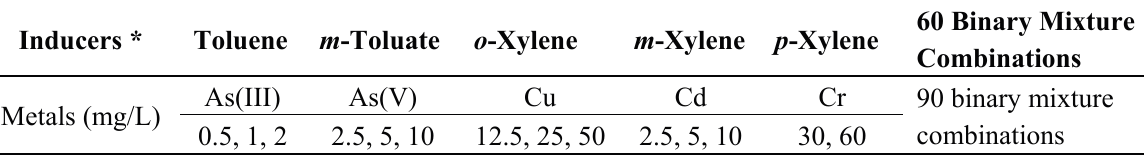
Table 1. Concentrations of each chemical in binary mixtures of inducers and metals